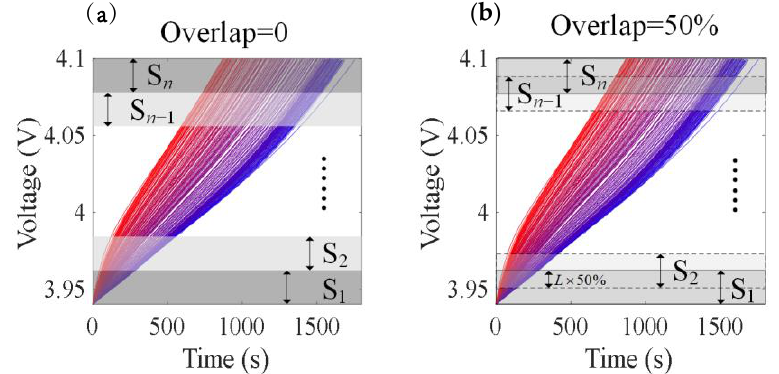
Figure 12. Segment division as the overlap is equal to ( a ) 0% and ( b ) 50%.